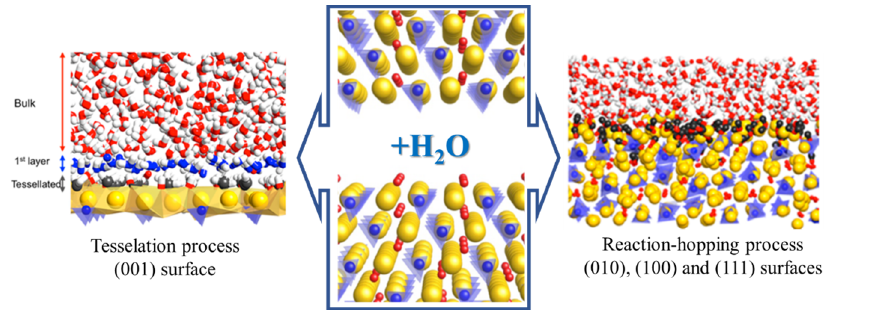
Figure 5. Different mechanism process of M3 ‐ C3S hydration depending on the hydrated surface. The hydrogen atoms from dissociated water molecules are represented in black to illustrate their absorption within the mineral structure. In tesselation process, the oxygen atoms of water molecule in stable monolayer are in grey, of the fist adsorbed layer are in blue light. Other atomic color codes are oxygen: red, calcium: yellow, silicon: blue, hydrogen: white, adapted from [95]. Copyright 2015 American Chemical Society. Based on conventional molecular methods, Pustovgar et